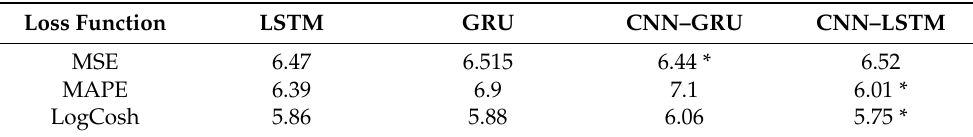
Table 6. MAE obtained by the models under study in terms of the used loss function on the traffic flow dataset. Loss Function LSTM GRU CNN–GRU CNN–LSTM MSE MAPE